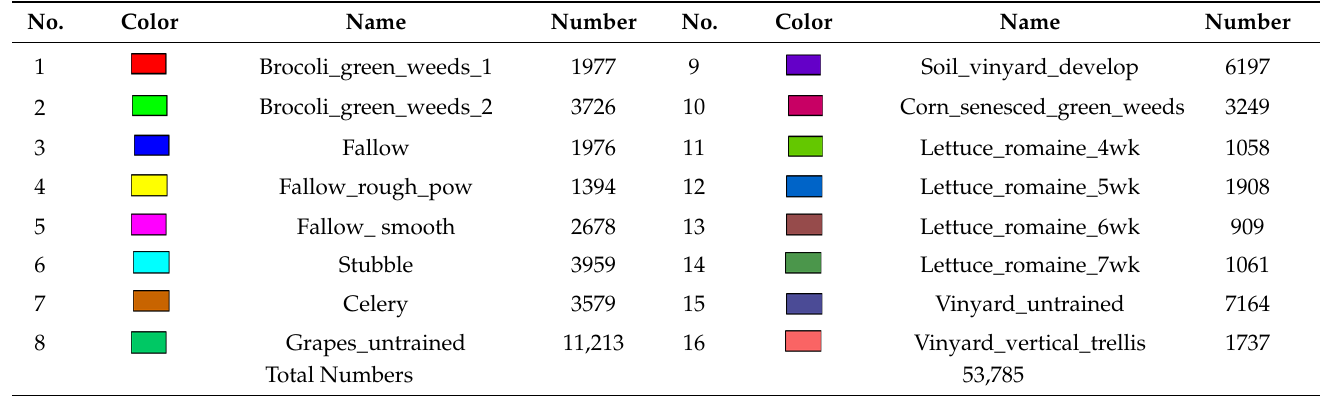
Table 2. Land cover types and total number of samples in the PaviaU dataset.